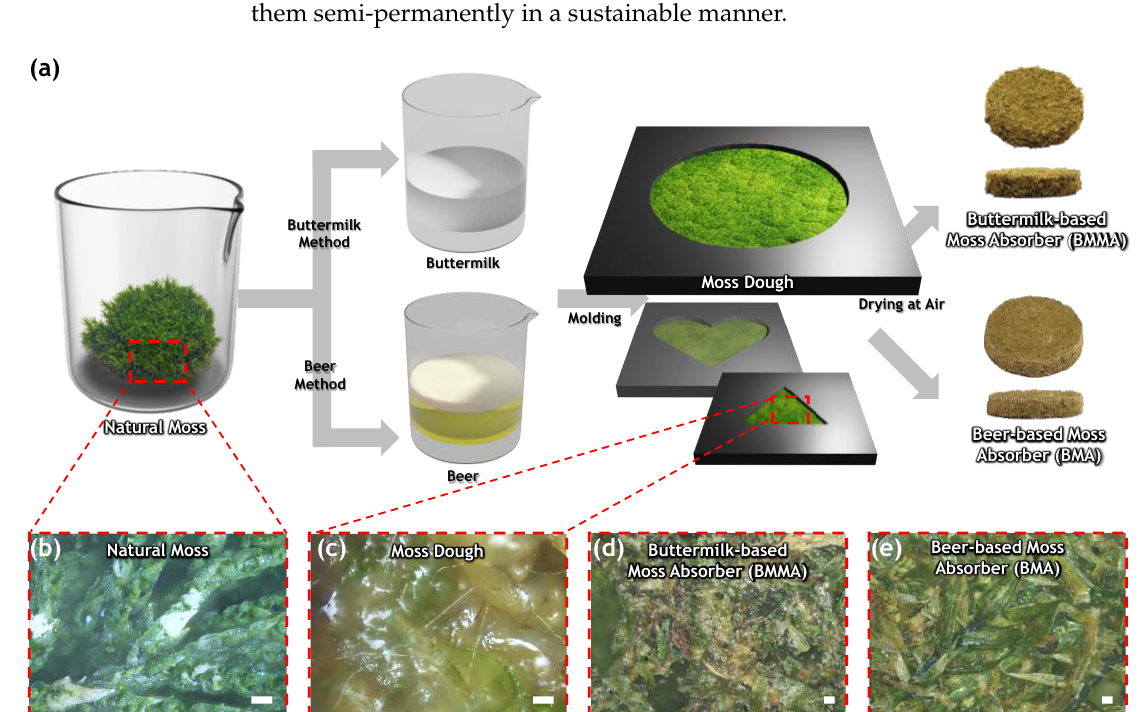
Figure 1. This is a figure. Schemes follow the same formatting. Fabrication and characterization of moss-based microstructural materials. ( a ) Schematic of the manufacturing process for various shapes of porous foam with moss-based dough using environmentally friendly materials of natural moss, buttermilk, and beer. Micrograph of ( b ) natural moss, ( c ) moss dough, ( d ) buttermilk-based moss absorber, and ( e ) a beer-based moss absorber (scale bar: 100 kJ·m−3 ). To demonstrate the structural feasibility of a randomly laminated moss-based struc- ture as a sound-absorbing material, the mechanical properties of nature-inspired structural materials were systemically compared with those of composite materials without starch- induced crosslinking [6,7,14,15]. As shown in Figure 2, the compressive strength of the non-starch-treated composite only reached approximately 141.1 kPa, because the moss was clumped together in a finely crushed state. After treatment with crosslinked starch, gelatinization can facilitate the interconnection of the moss; the textural properties of moss- based microstructural composites include strong physical interactions between mosses. Furthermore, the crosslinking area increases with the starch content, forming more ran- domly arranged and well stacked random structures [16,39]. The beer-based moss material exhibited a relatively high compressive strength of approximately 2.35 MPa, which was more than 75 times greater than that of the starch-untreated composite (Figure 2d). In addition, the BMMA50 (buttermilk-based sound absorber) showed a high compressive strength of approximately 1 MPa. However, the energy-dissipation density of the BMMA50 decreased from approximately 90 kJ · m − 3 to 4 kJ · m − 3 over 10 cycles, as measured by a cycle-compression test (Figure 2f). This is because the initially formed moss structure was crushed and collapsed while being compressed to maintain its deformed